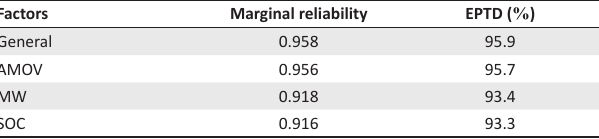
TABLE 4: Stage-1 results: Basic internal assessment (Part